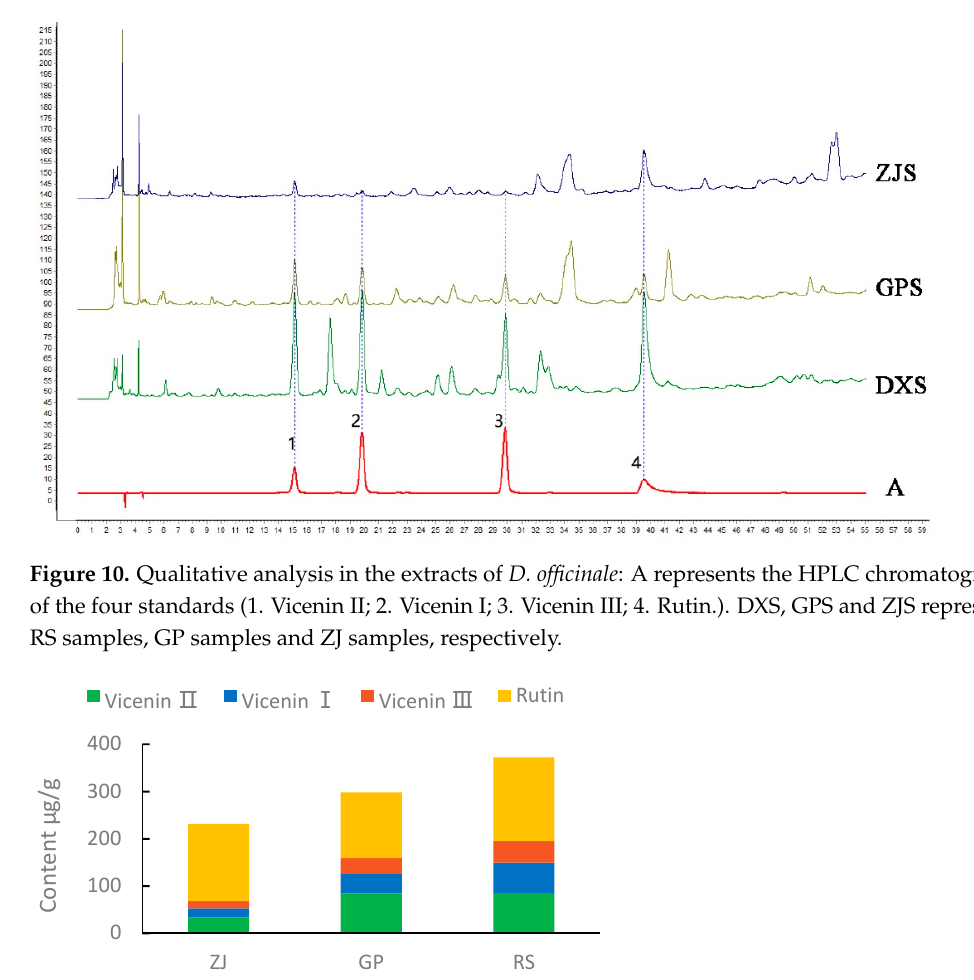
Figure 11. Content of four main flavones in ZJ, GP, and RS samples, including Vicenin II, Vicenin I, Vicenin III, and Rutin.